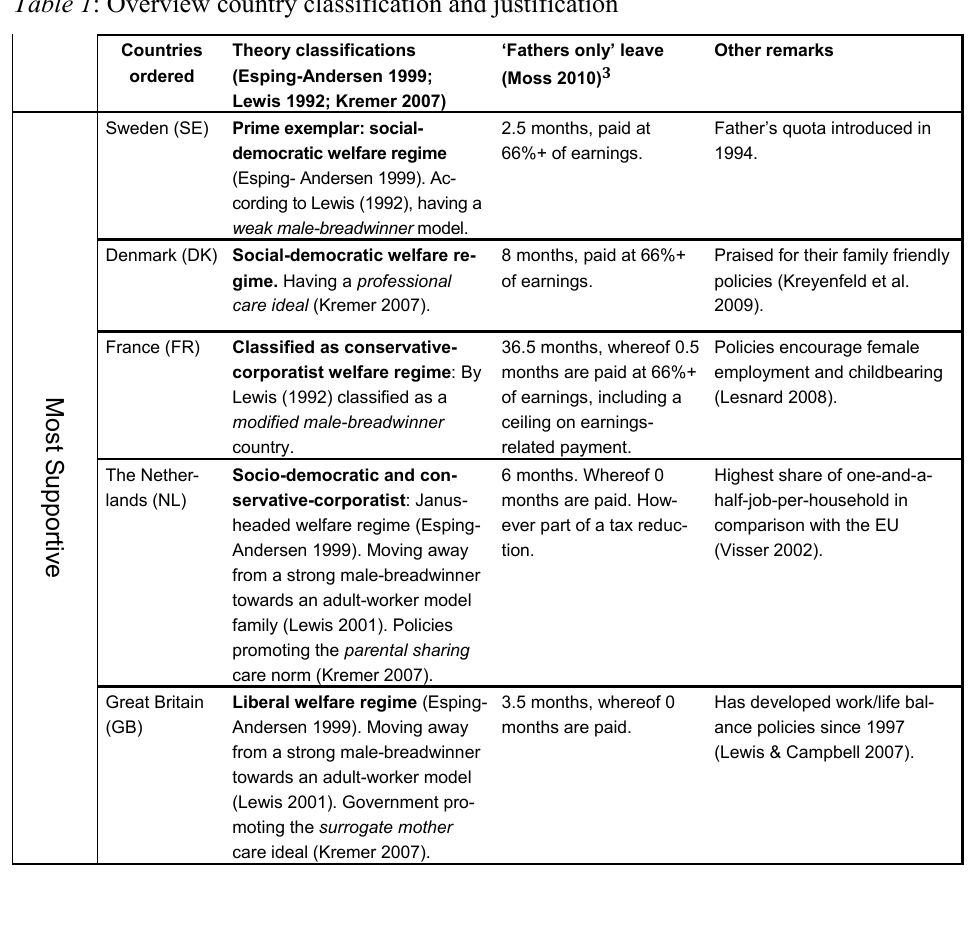
Table 1 : Overview country classification and